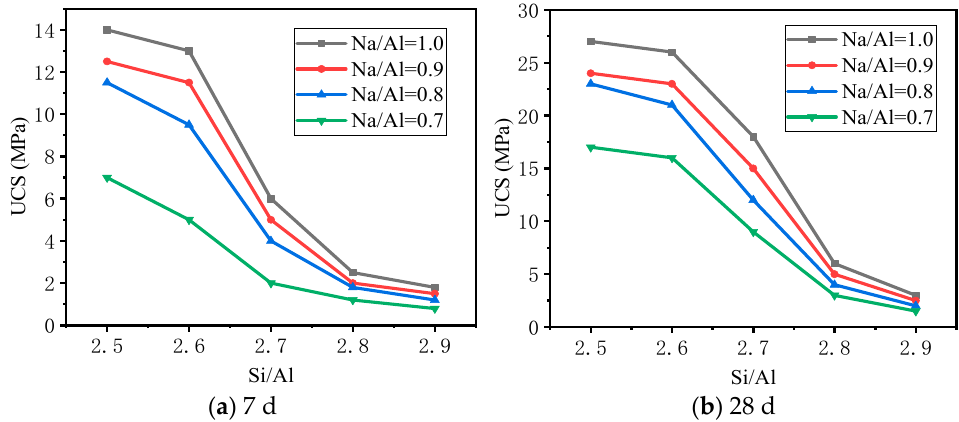
Figure 6. Effects of different Si/Al and Na/Al ratios on unconfined compressive strength of slag – fly ash geopolymer.